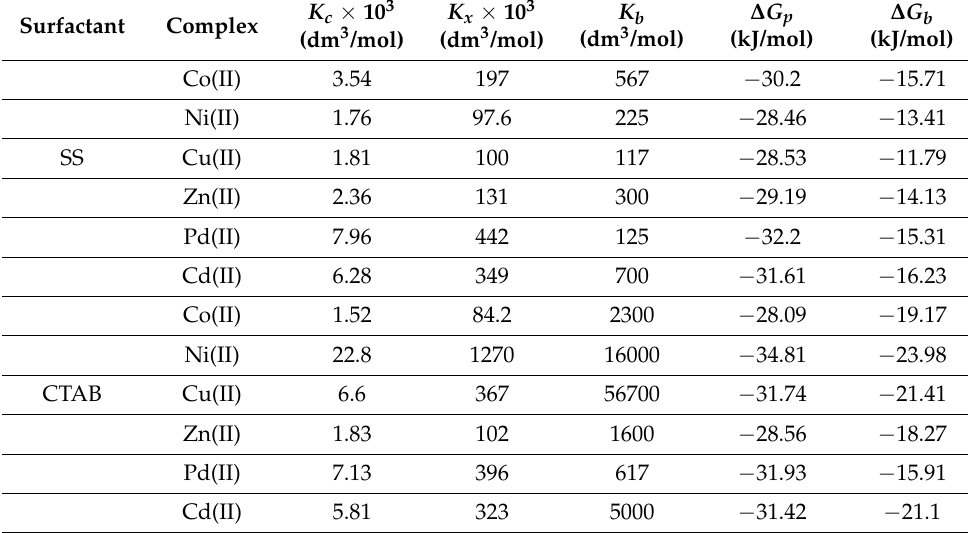
Table 2. Partitioning and binding parameters of M(II) complexes in micellar media.